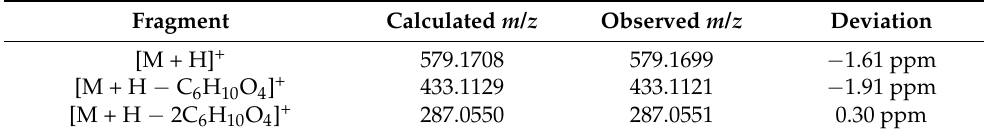
Table 3. The deviations between calculated and observed m / z values of each fragment derived from compound 3